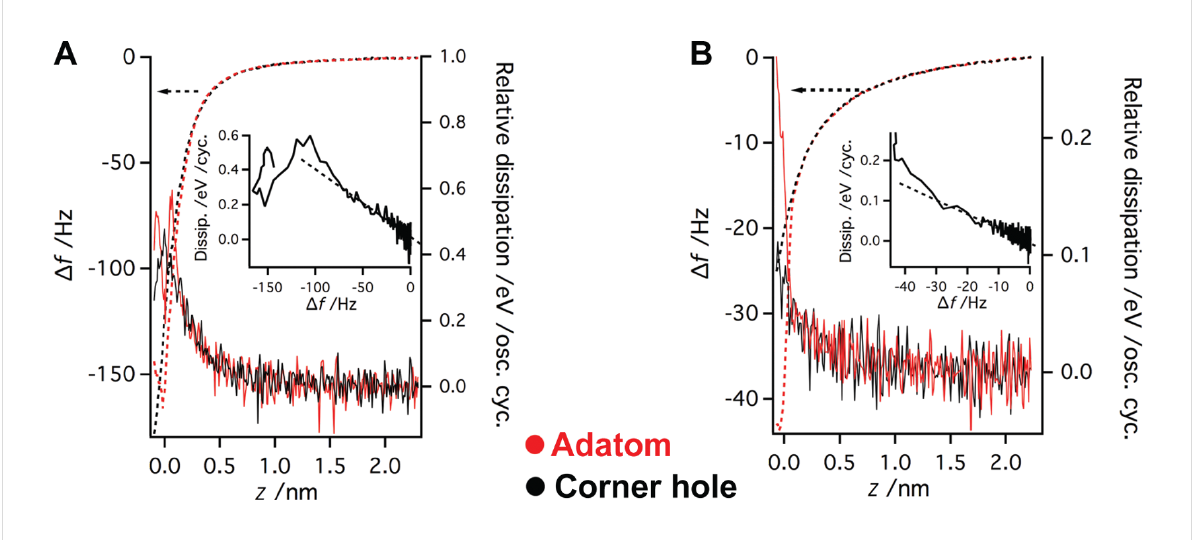
Figure 10: Relationship between the frequency shift and the dissipation for the reactive tip termination (A) and also for the less reactive one (B). Dissipation is plotted with a continuous line and the frequency shift with a dashed line. The corner hole data is marked with black and the adatom with red. In the insets the dissipation is plotted as a function of the frequency shift for the adatom data.